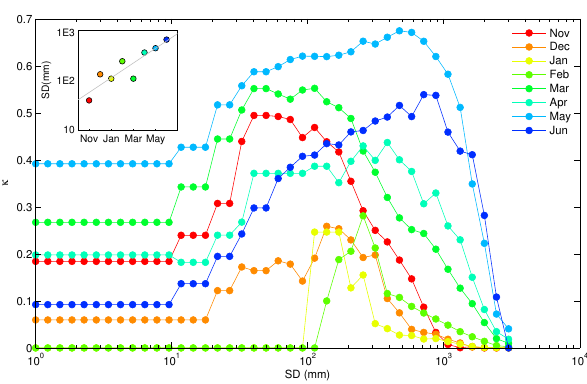
Figure 5. Evolution of the κ coefficient with the value of the snow depth detection threshold for each month of the snow season. Here only the telenivometers data and the MOD10A1 product were con- sidered. The snow depth value giving the maximum κ was extracted for each month and plotted against the month (inset). The linear fit was calculated with log-transformed values of the SD (Pearson’s correlation R = 0 . 90, p = 0 . 002).